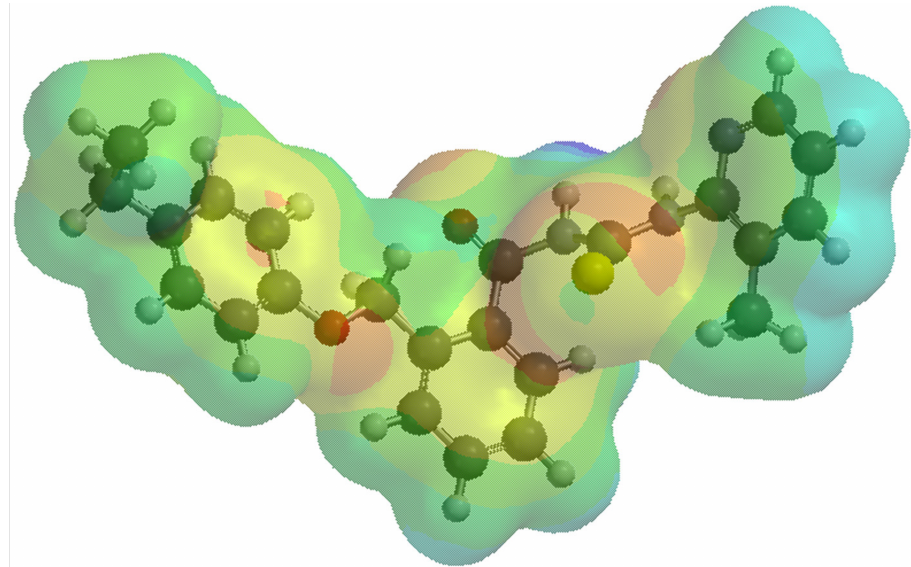
Figure 5. Molecular electrostatic potential map (of the electronic density) for the compound 1d . A red color or shades of red mark a negative potential. On the other hand, shades of blue indicate a positive potential. Supporting information with respect to the molecular electrostatic potential map representation for every chemical compound included in the current study is provided in the Supplementary Materials, Figure